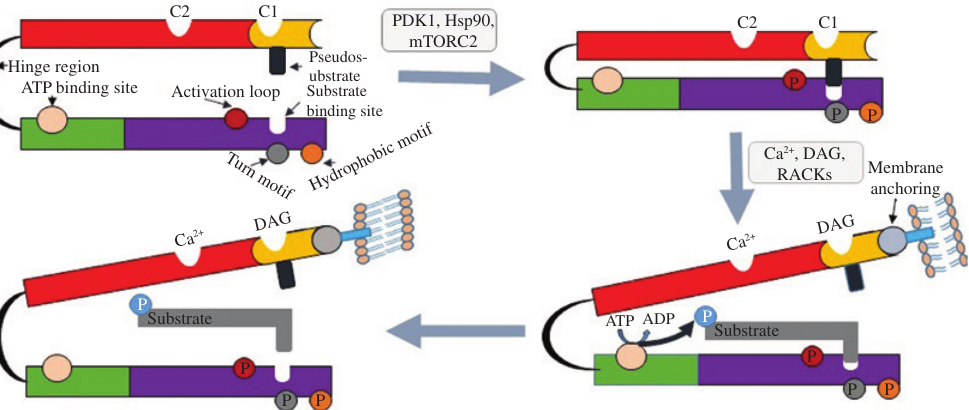
Figure 2: Newly synthesized PKC- α shows an open confirmation in which the substrate-binding cavity is unmasked and allows phosphoryla- tion by PDPK-1 at the activation